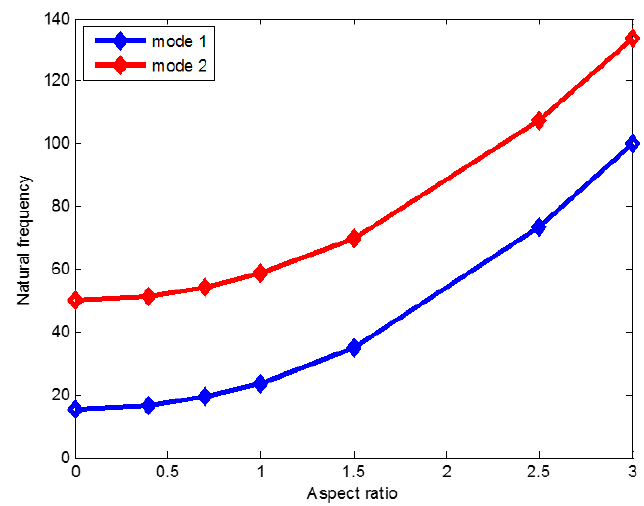
Figure 10. Variation of Aspect ratio on SS edge condition